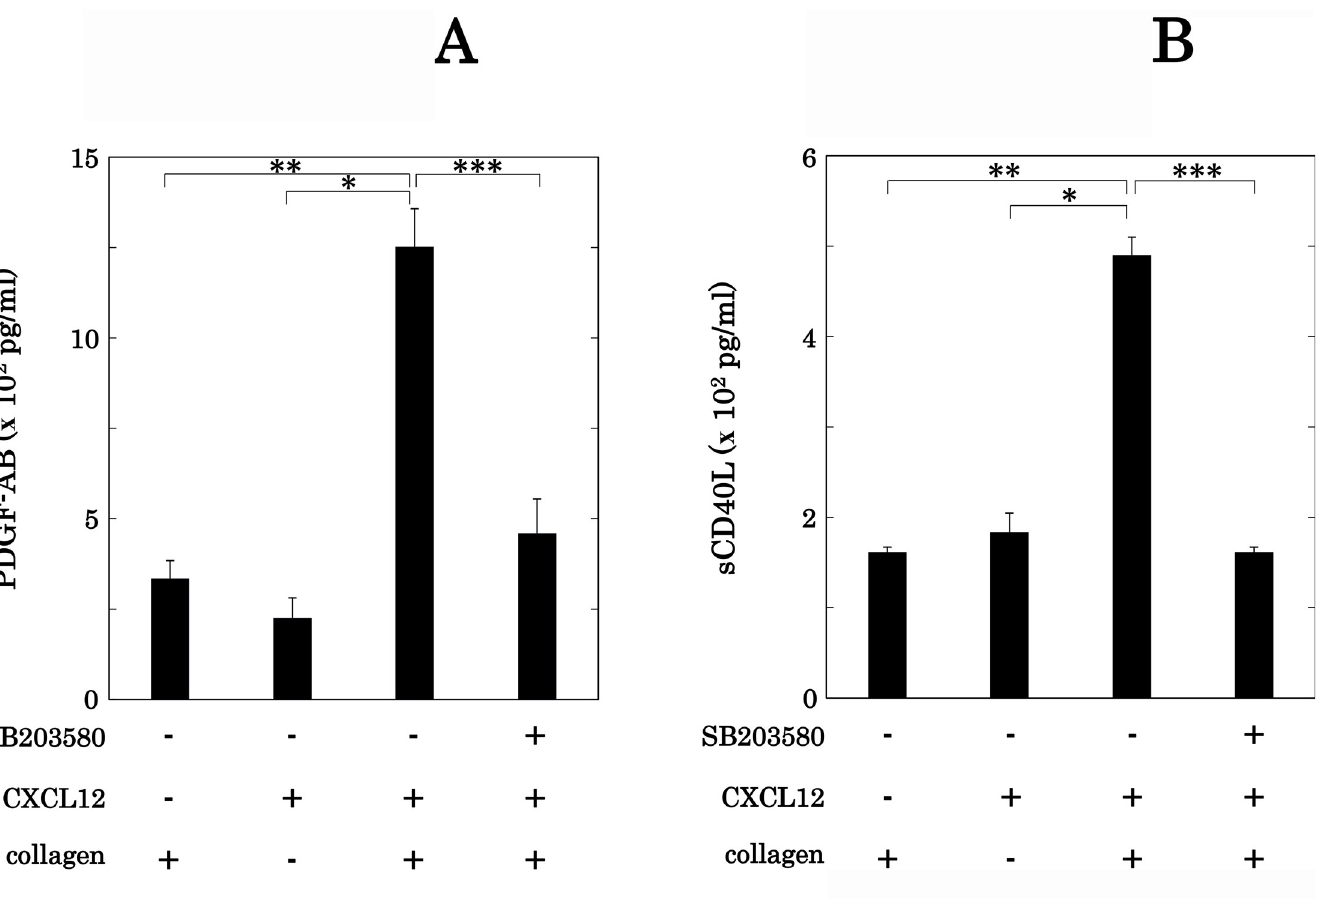
Fig 11. Effects of SB203580 on the secretion of PDGF-AB and the release of sCD40L from human platelets induced by simultaneous stimulation with collagen and CXCL12 in low doses. PRP was pretreated with 30 μ M of SB203580 or vehicle for 3 min and then simultaneously stimulated by 0.1–0.2 μ g/ml of collagen and 10 ng/ml of CXCL12 for 5 min (A) or 15 min (B). The dose of collagen achieving a % transmittance of 10%-30% recorded in an aggregometer was adjusted individually. The reaction was terminated by the addition of ice-cold EDTA (10 mM) solution. The conditioned mixture was centrifuged at 10,000 × g at 4˚C for 2 min, and the supernatant was then subjected to ELISA for PDGF-AB (A) or sCD40L (B). The results from of 5 independent individuals are shown. Each value of PDGF-AB (A) or sCD40L (B) represents the mean ± SEM. � p < 0.05, compared to the value of CXCL12 alone. �� p < 0.05, compared to the value of collagen alone. ��� p < 0.05, compared to the value of simultaneous stimulation of collagen and